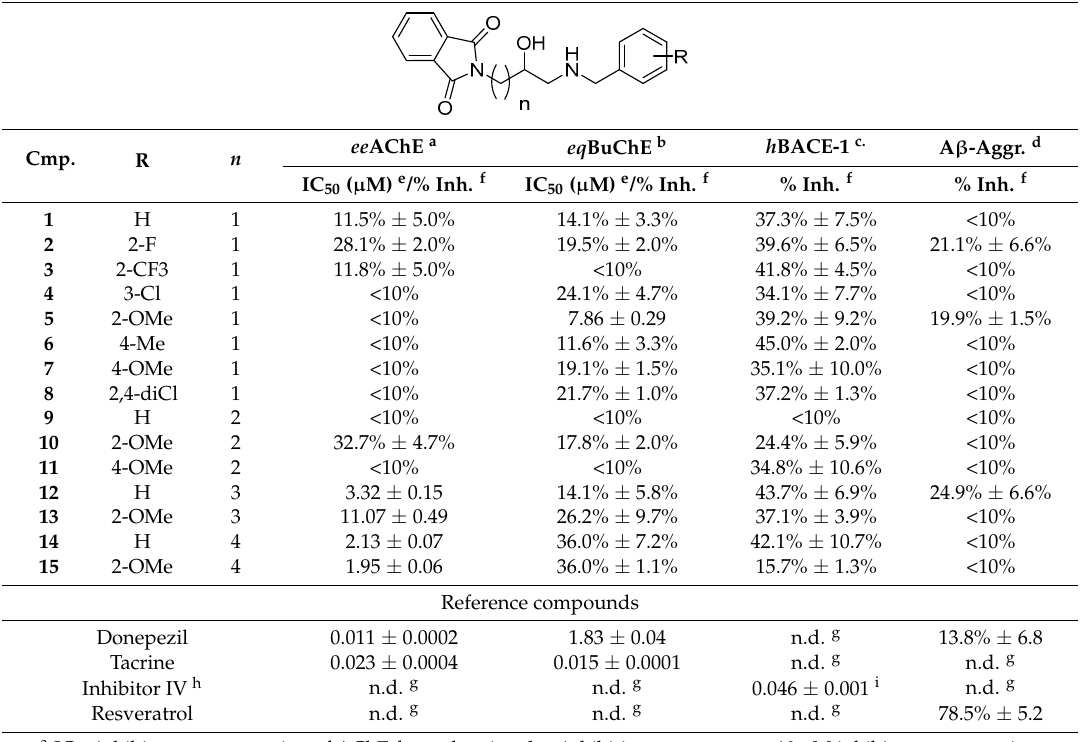
Table 1. Inhibitory activity on ee AChE, eq BuChE, h BACE-1, and A β for the presented compounds.